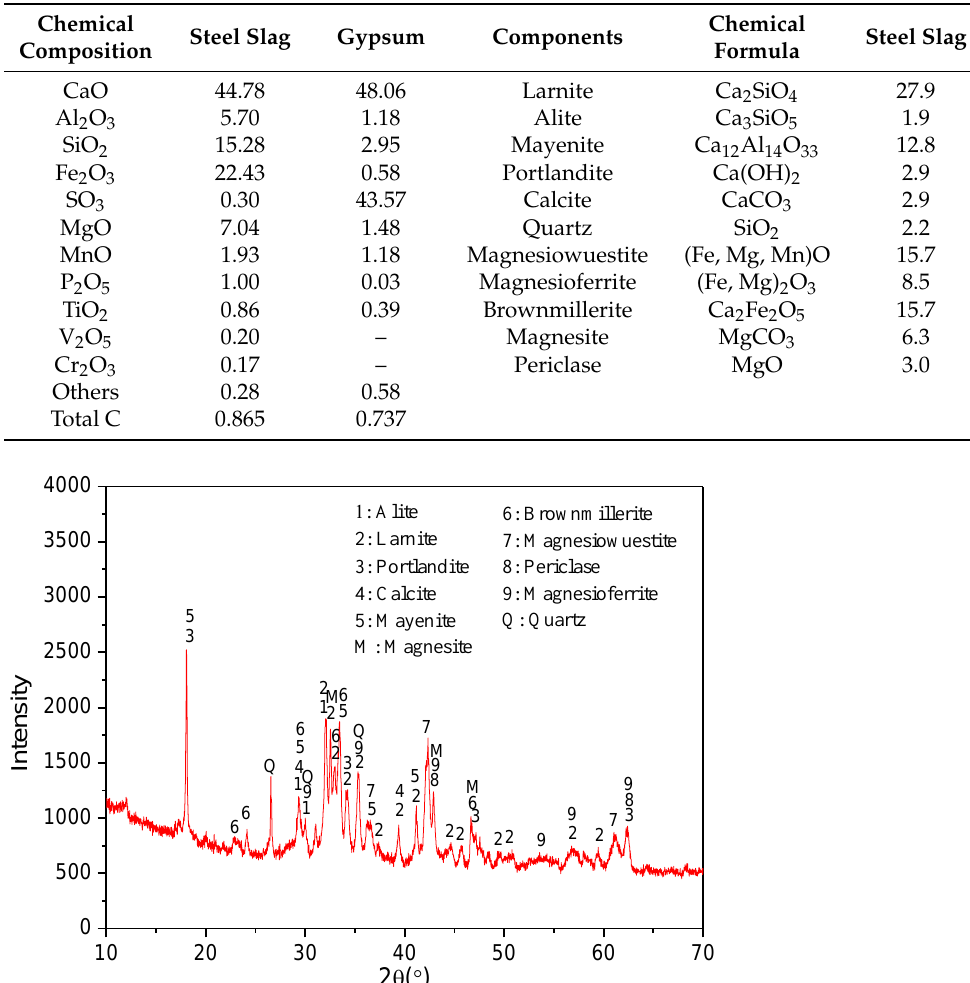
Table 1. Chemical compositions of the steel slag and gypsum (wt %).